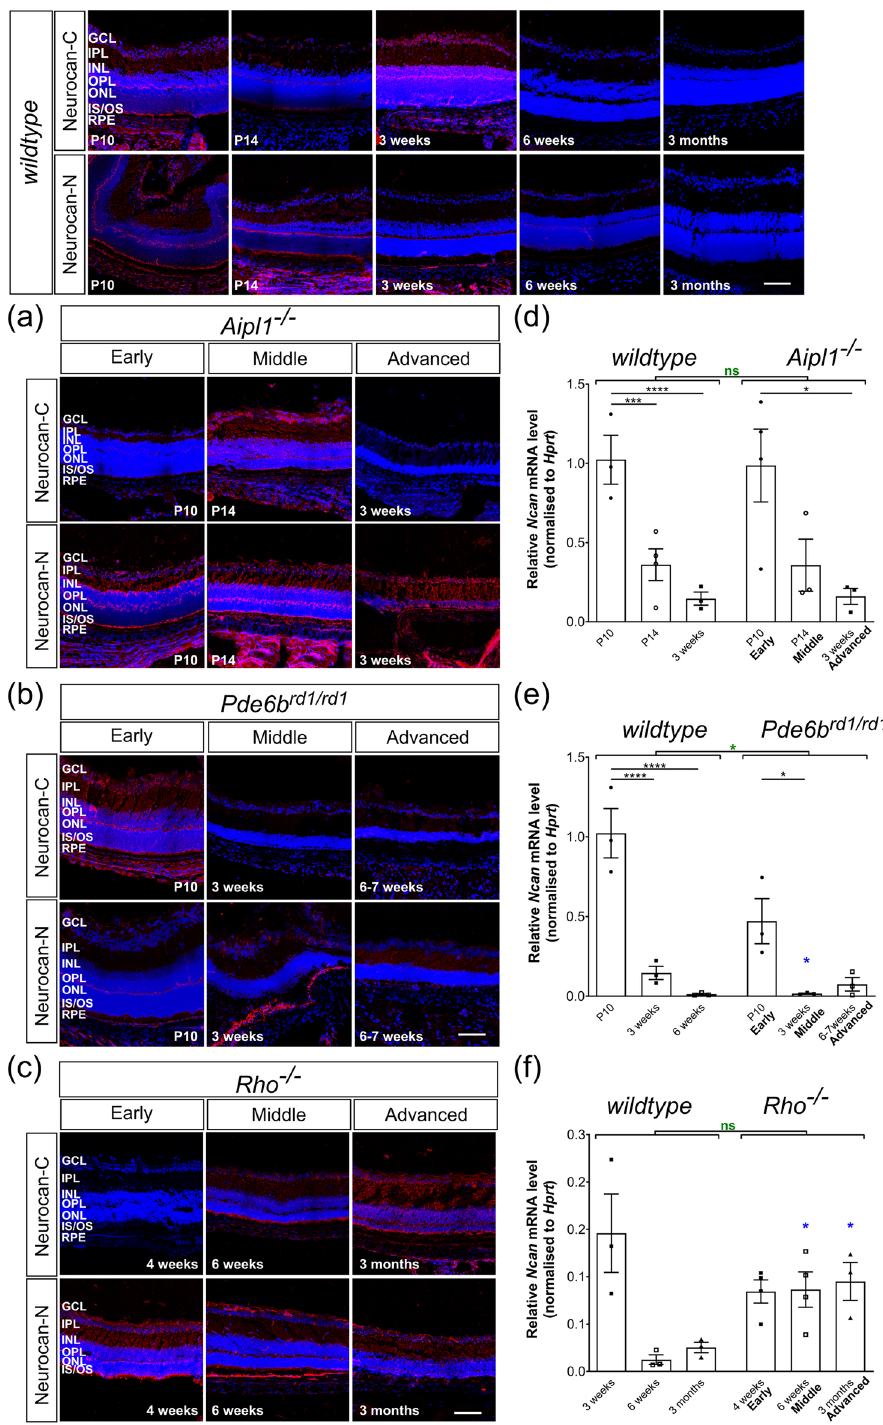
Figure 5. Neurocan expression decreases with time and is unaffected by degeneration. Neurocan immunolabelling ( red ) was distributed throughout all the layers of the retina and low levels of mRNA transcripts were observed in adult retinae in all models. mRNA levels shown for wildtype are the same as in Fig. 1d. ( a ) ( b ) Immunolabelling of the Neurocan C-terminal fraction typically decreased in intensity in Aipl1 -/- and Pde6b rd1/rd1 mice with time, while that of the Neurocan N-terminal fraction remained constant in these models. ( d ) ( e ) mRNA levels of Ncan decreased with time in Aipl1 -/- , Pde6b rd1/rd1 and wildtype mice. ( f ) Ncan mRNA and ( c ) immunolabelling for both Neurocan-C and -N were largely unchanged across degeneration in Rho -/- mice. Scale bar, 100 µm. * p < 0.05, ** p < 0.01, *** p < 0.001, **** p < 0.0001 (one-way ANOVA test with Bonferroni’s correction, black ; unpaired t-test for age-matched comparisons between wildtype and disease model, blue ; two- way ANOVA test applied for assessments of change over time, red ). ONL—outer nuclear layer; OPL—outer plexiform layer; INL—inner nuclear layer; IPL—inner plexiform layer; GCL—ganglion cell layer. Nuclei are counter stained with Dapi ( blue